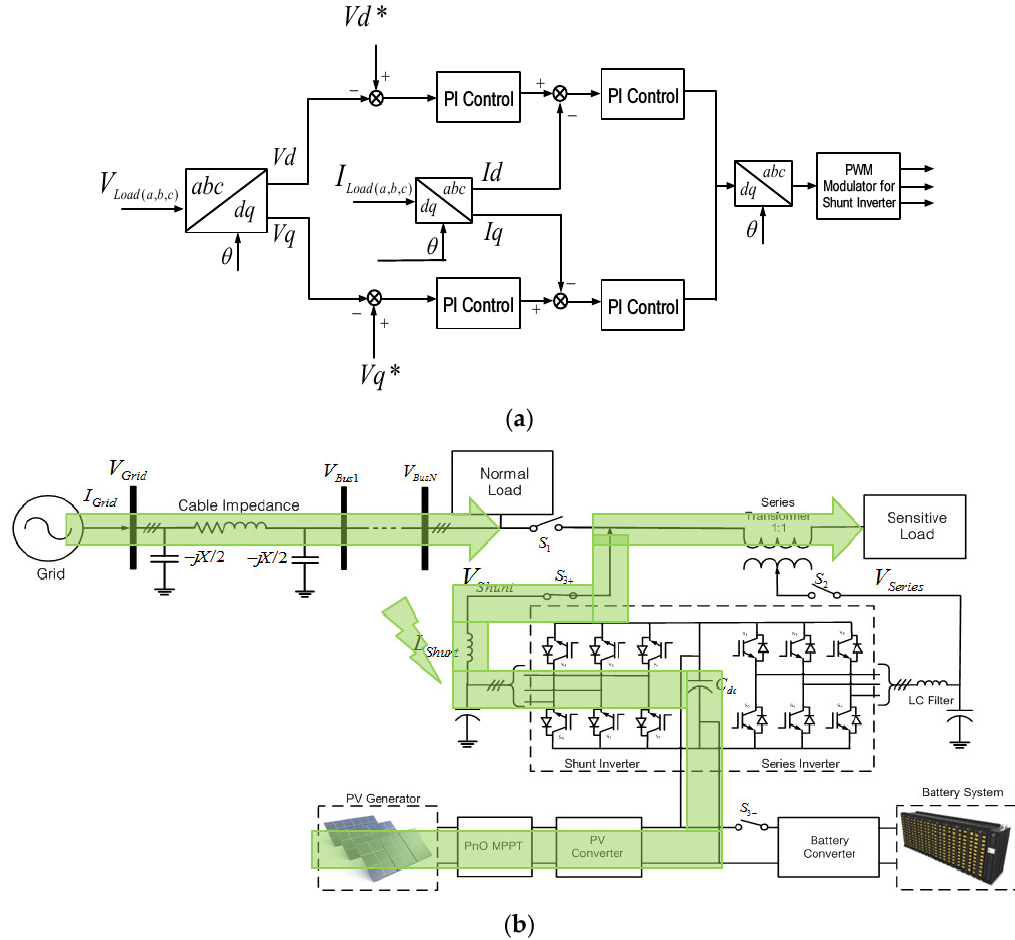
Figure 8. Stand-alone mode: ( a ) Control scheme; ( b ) power flow condition.